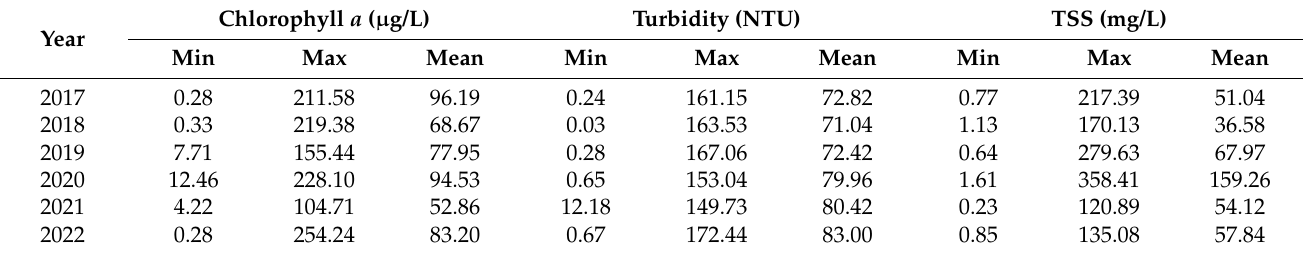
Table 6. Selected regression model for the retrieval of yearly WQPs from Sentinel 2A MSI bands and descriptive statistics of the in situ-measured and predicted water quality